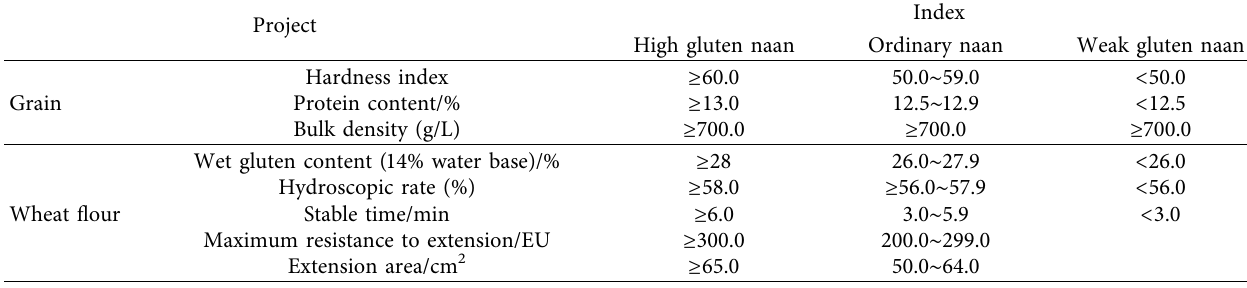
Table 10: Quality index of special wheat varieties with different types of Naan.